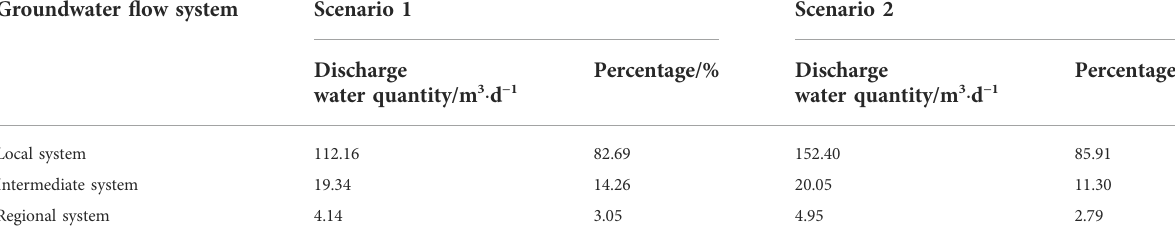
TABLE 3 The discharge of various groundwater fl ow systems of the pro fi